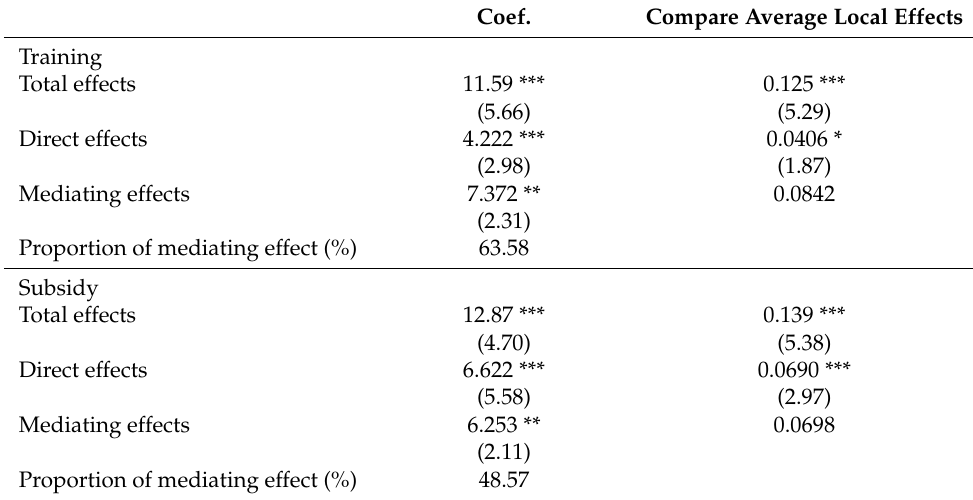
Table 4. The decomposed mediating effect of different policy measures.